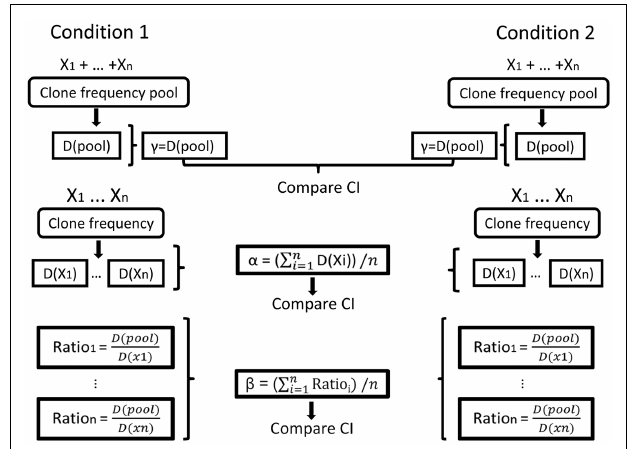
FIGURE 5 | Illustration of the calculation of repertoire diversity . First, the diversity indices (Shannon entropy, Simpson concentration index, etc.) are calculated for the pool of samples in each condition and also for each sample separately (samples are denoted by X 1 , ... , X n . Diversity indices are denoted by D (sample) or D (pool)). Next, the distribution measures ( α , β , γ ) are calculated for each condition using the samples. γ is the pool diversity, α is the mean sample diversity, and β for each sample is γ divided by D (sample). Finally, the CIs of the distribution measures are compared between the